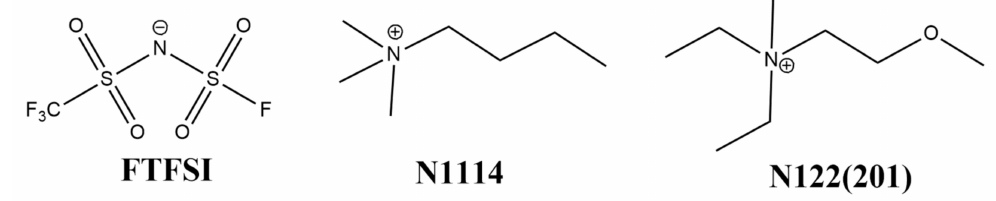
Figure 1. Chemical structure of the FTFSI − anion, and N1114 + and N122(2O1) +